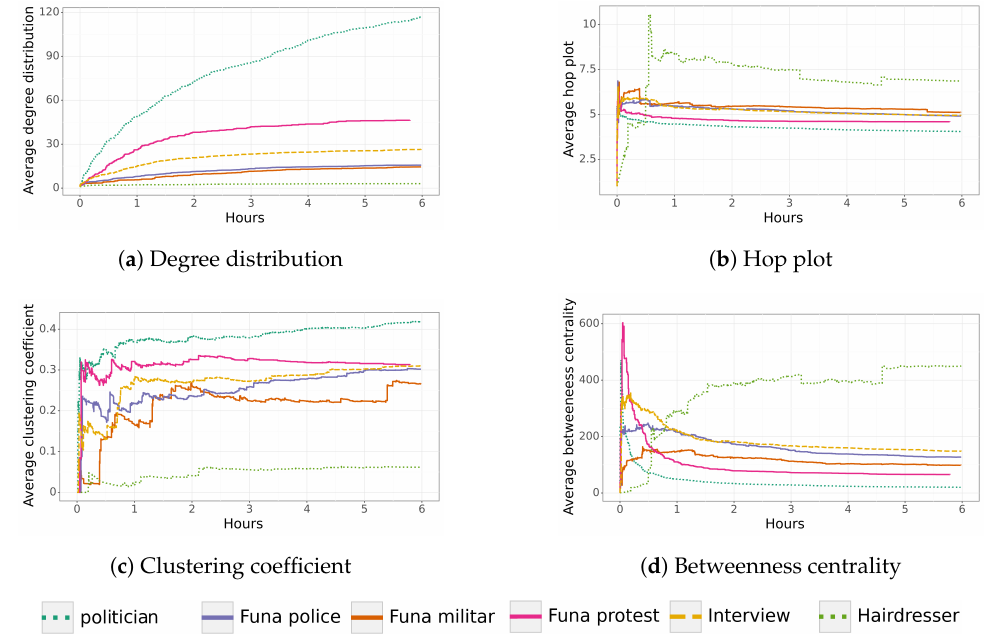
Figure 8. Network characteristics of all of the analyzed trends over